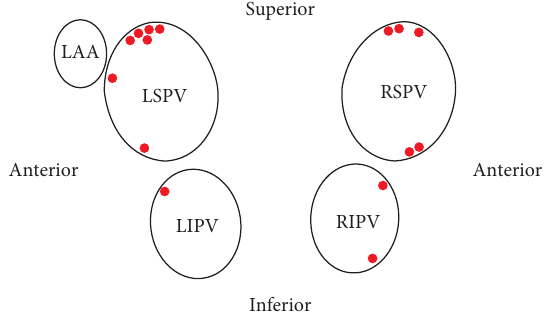
Figure 1: Te large circles indicate the left superior pulmonary vein (LSPV), left inferior pulmonary vein (LIPV), right superior pulmonary vein (RSPV), right inferior pulmonary vein (RIPV), and left atrial appendage (LAA). Te distribution of steam pop (SP) locations during radiofrequency catheter ablation (RFCA) for PVI is marked in red points in the posterior-anterior view of the left